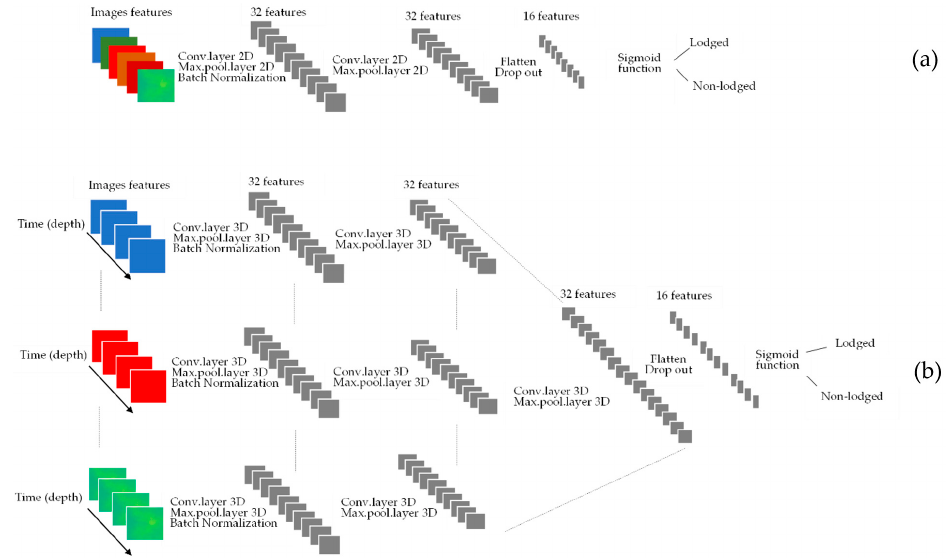
Figure 3. Diagram of custom CNN architectures utilized to assess lodging. The 2D-CNN ( a ) and 3D-CNN models ( b ) for lodging detection: CNN architectures for lodging severity can be found in Supplemental Materials, Figures S1a and S1b.